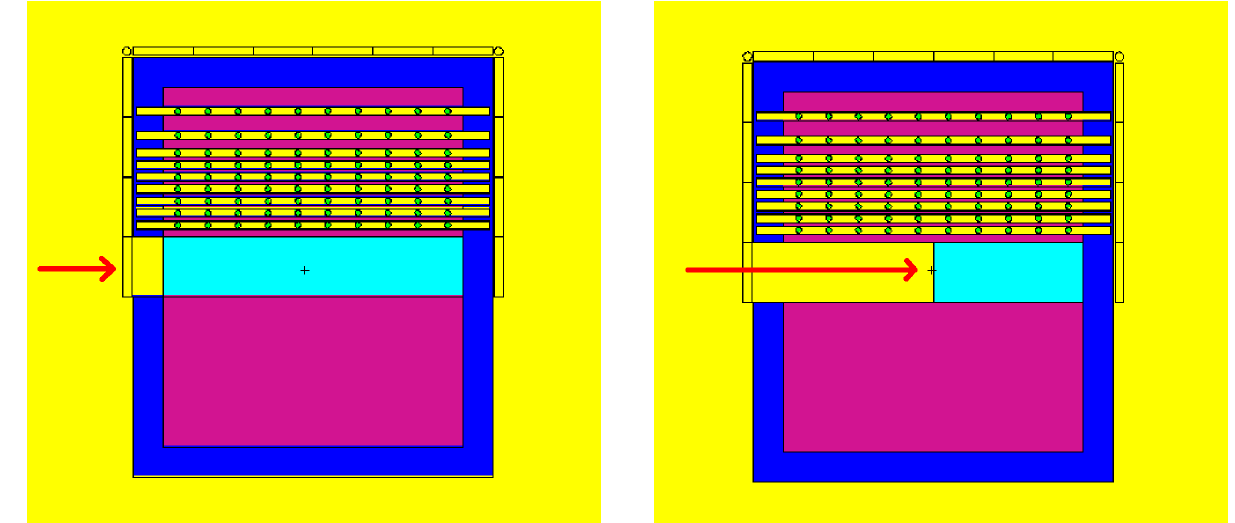
Figure 4. B-URAN sectional view, graphite target, red arrow is a symbol of proton beam (created by MCNP)